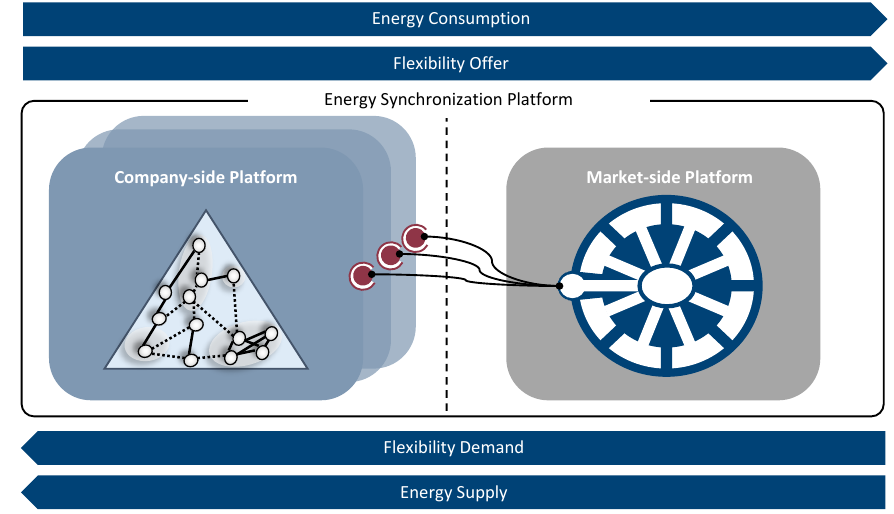
Figure 2. Concept of the energy synchronization